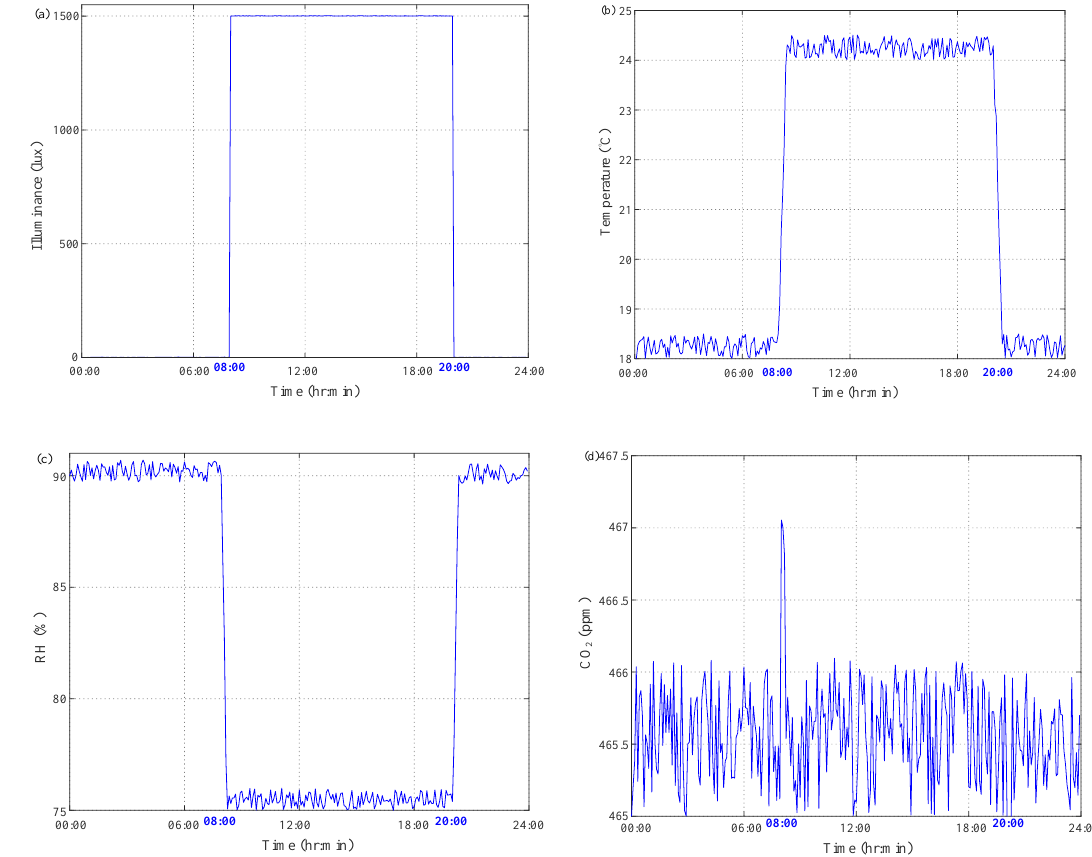
Figure 7. 24-h measurement results of on-site monitoring for primordia culture. ( a ) Illuminance; ( b ) temperature; ( c ) RH; ( d ) CO 2 .